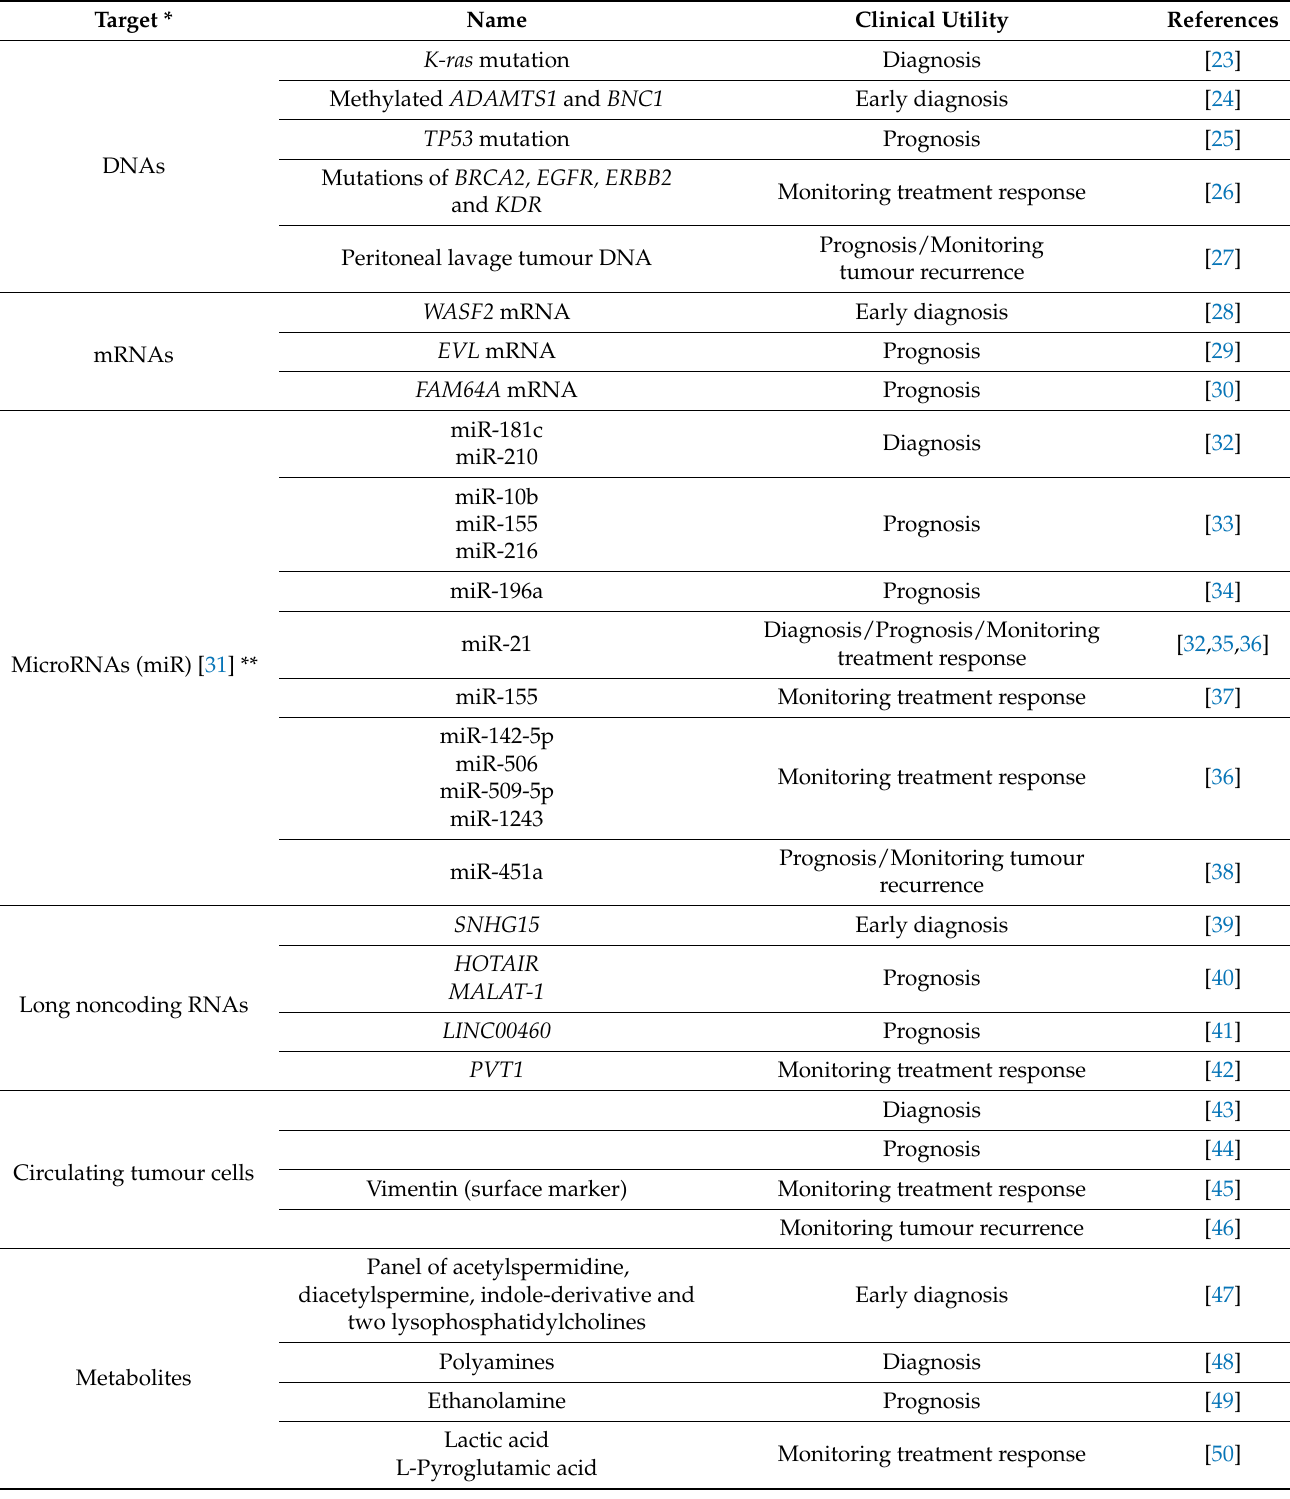
Table 1. Selected recently identified biomarkers for